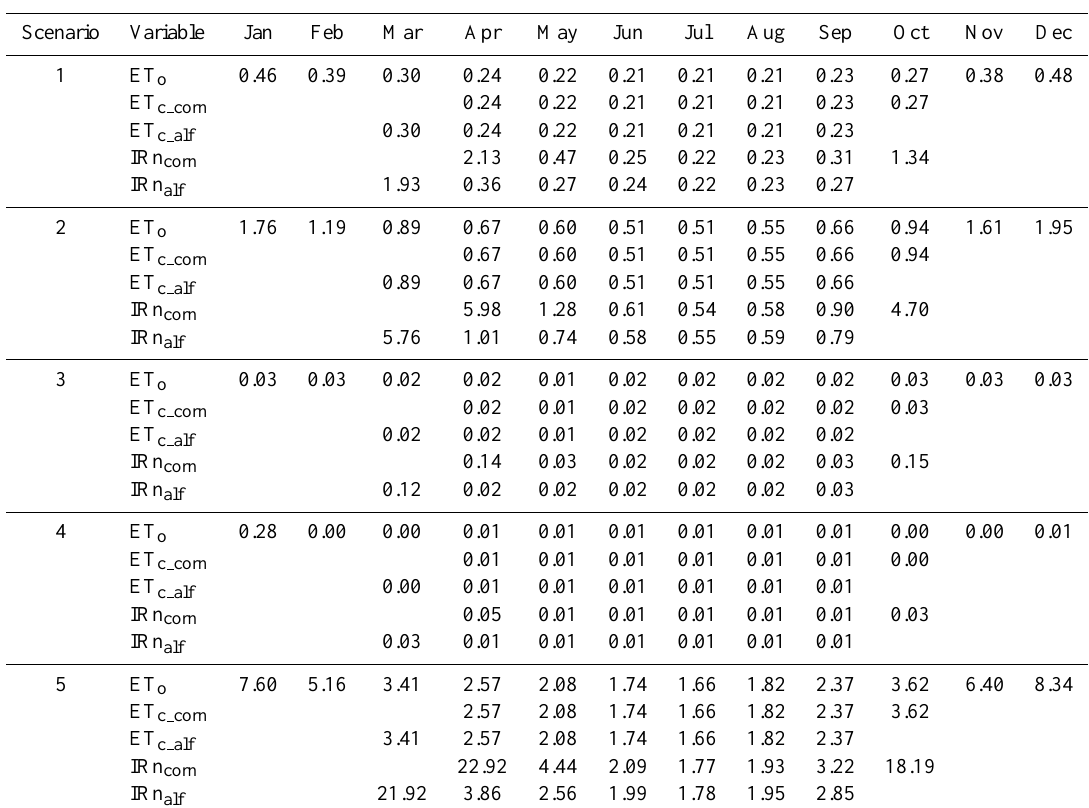
Table 9. Associated error ( ± 2 σ , %) to average monthly values (Table 8) under the five scenarios considered during the period 2004–2011 for irrigation district of Riegos del Alto Arag´on (RAA, Gra˜n´en weather